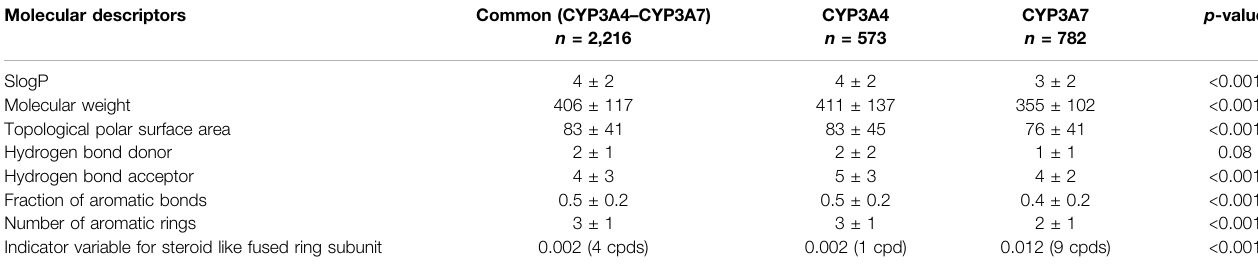
TABLE1| Comparisonofmoleculardescriptorsbetweencommon(bothCYP3A4and-CYP3A7),CYP3A4-selectiveandCYP3A7-selectivehits.Datashownasmean±SD. Molecular